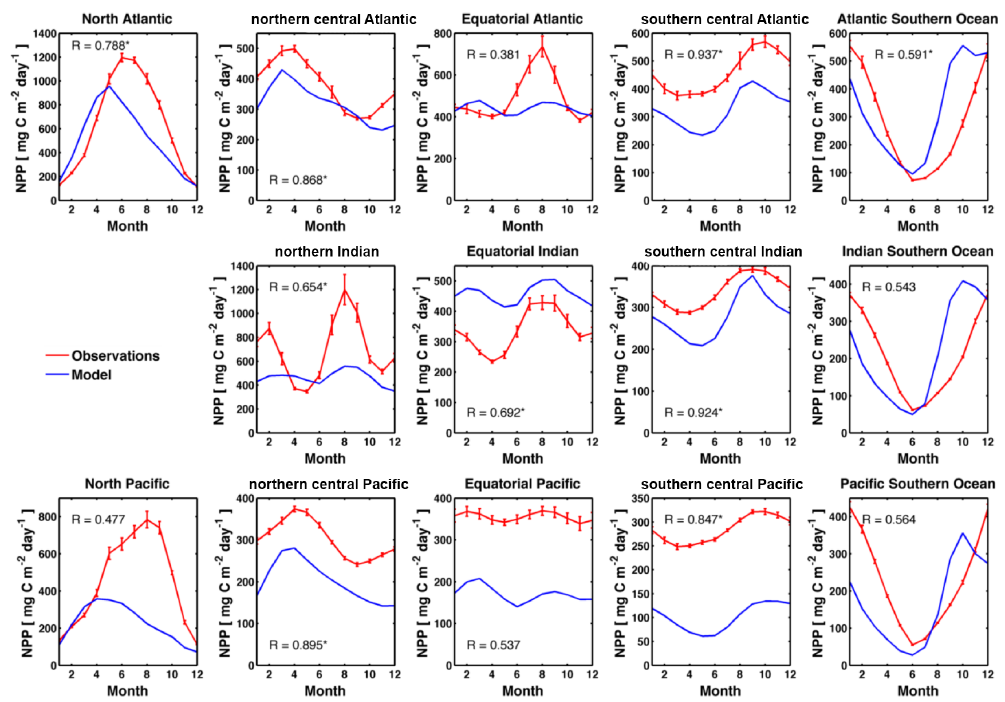
Figure 13. Mean NPP over the year in the ocean basins depicted in Fig. 3. The correlation coefficient is written in each plot, and the statistically significant correlations ( p values < 0 . 05) are marked with ∗ .